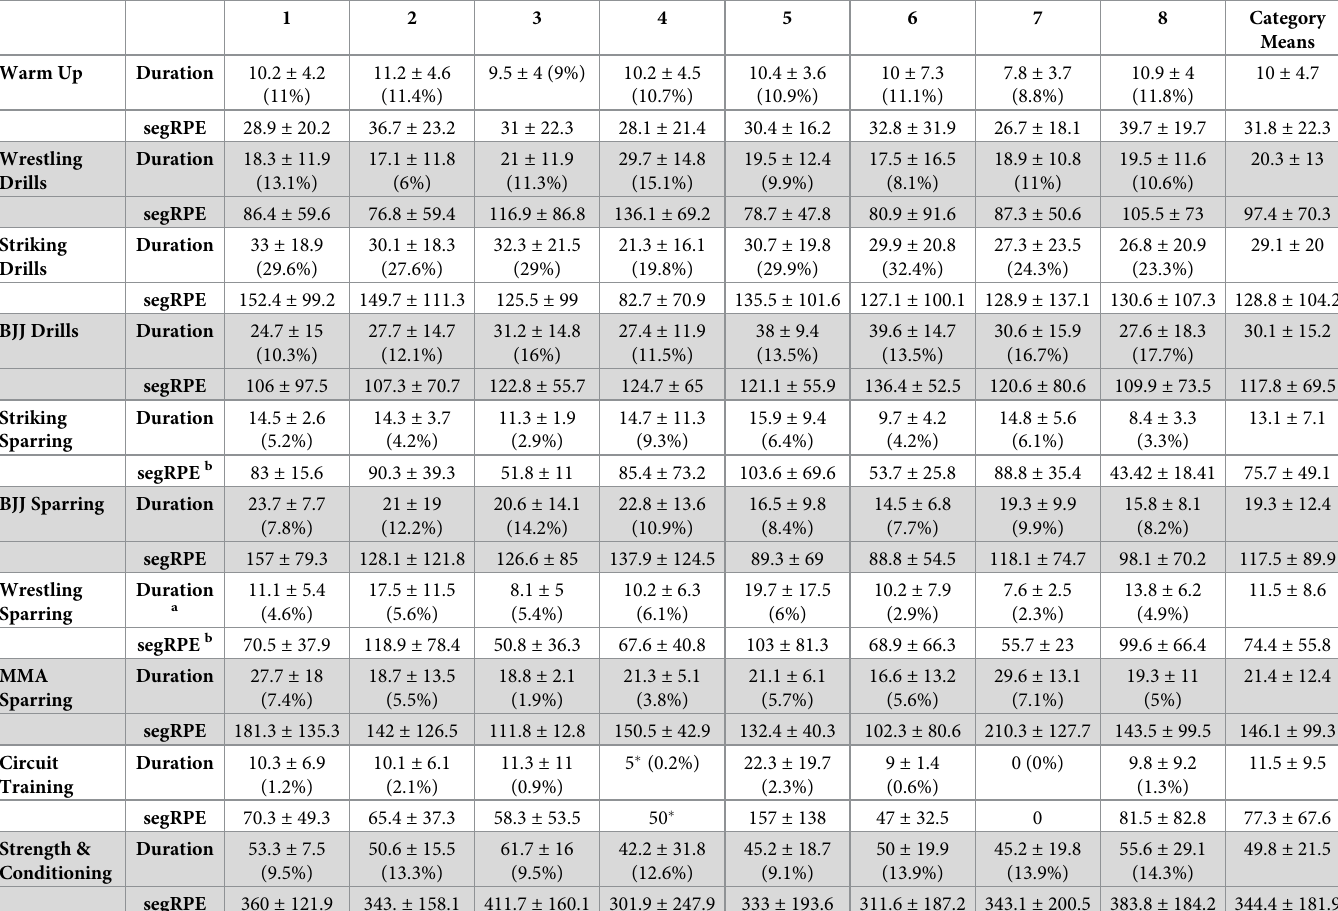
Table 3. Category duration (mins) and segmented sessional RPE (AU) per week and mean per